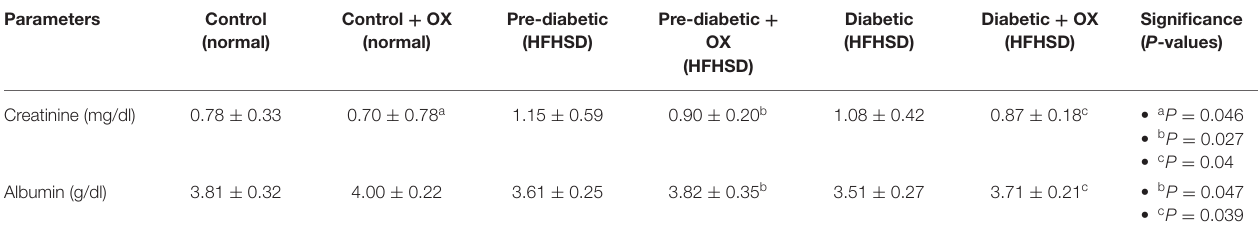
TABLE 3 | Alterations (mean ± SEM) of creatinine and albumin in different groups of Wistar rats.